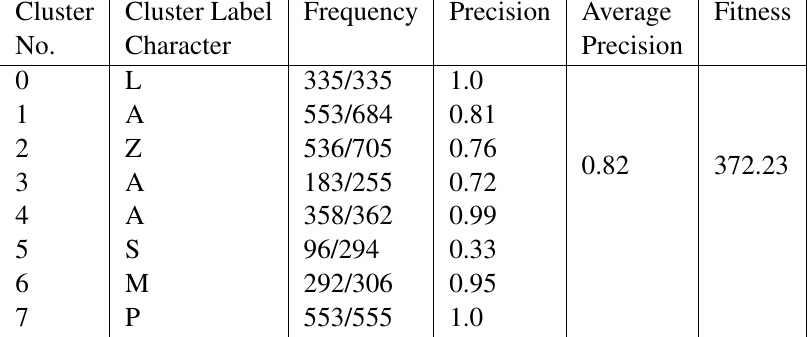
Table 8: Rough K-means algorithm clustering for selected set of